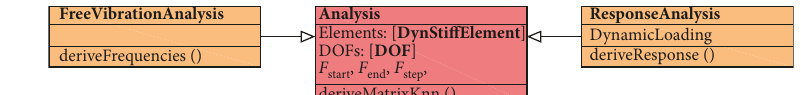
Figure 5: Example of possible software extension. Table 2: Dimensionless frequencies ω ∗ � ωa ( ρ (1 − ] 2 )/ E ) 1/2